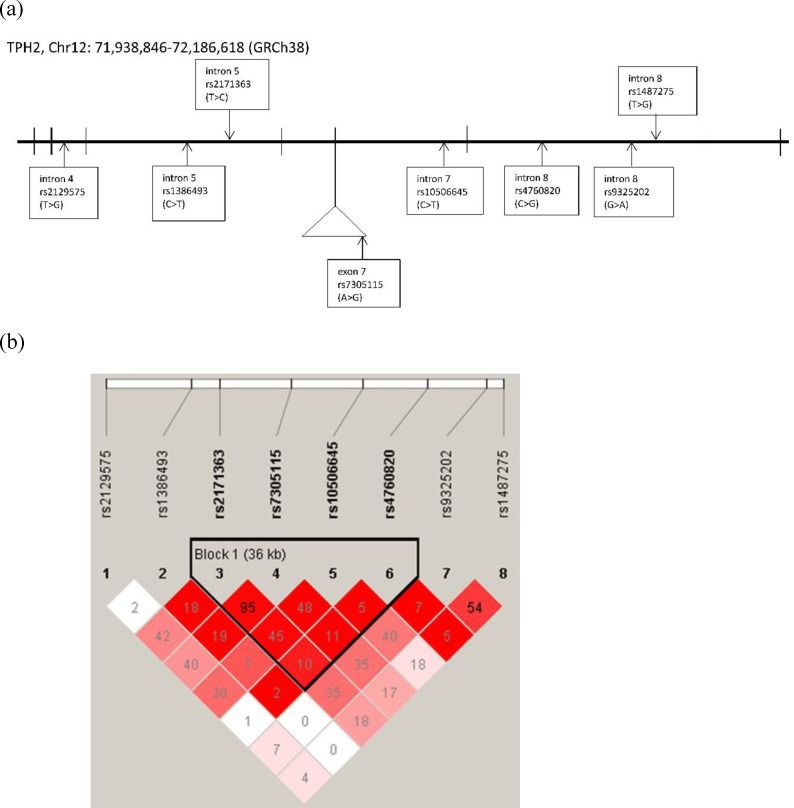
The genomic location and linkage disequilibrium pattern of the TPH2 genetic polymorphisms included in this study.Genomic locations of the genetic polymorphisms on chromosome 12. Haploview 4.2 software was used to estimate the linkage disequilibrium blocks. The R2 values were shown in squares; range from 0 to 0.95 and higher values indicate higher degree of correlation.